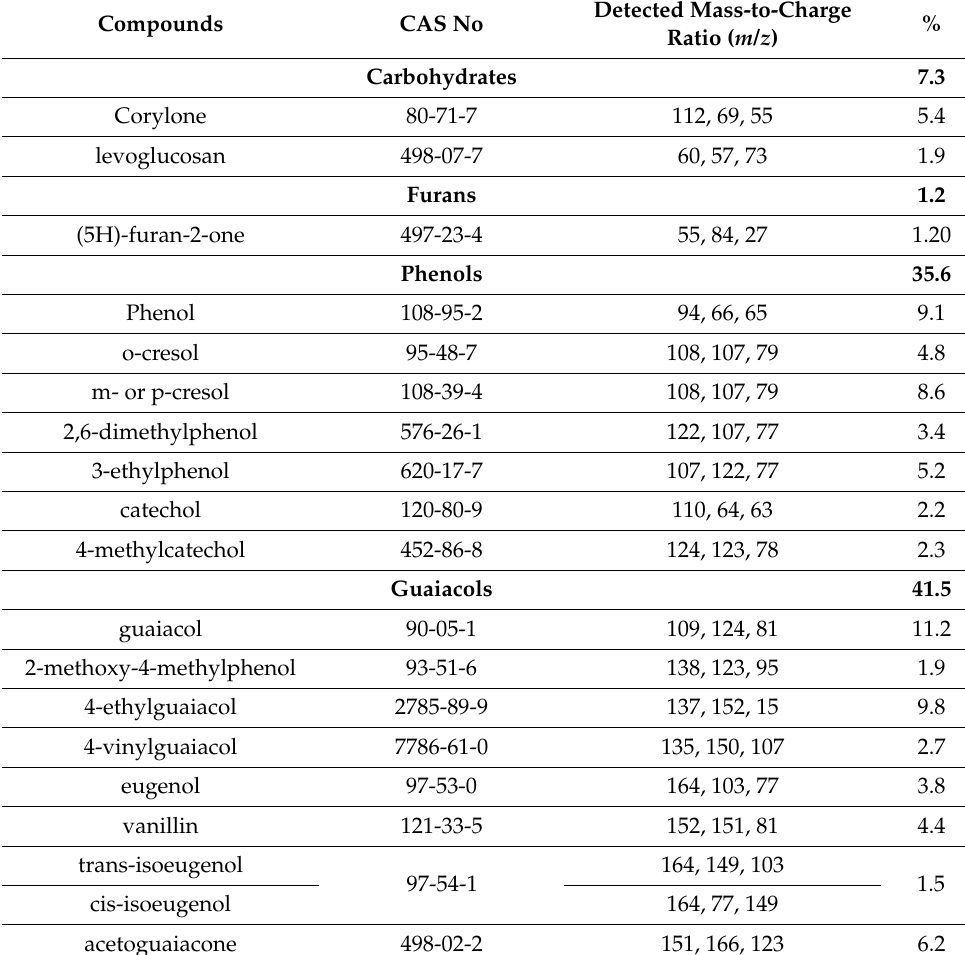
Table 1. The chemical composition of tar in syngas.